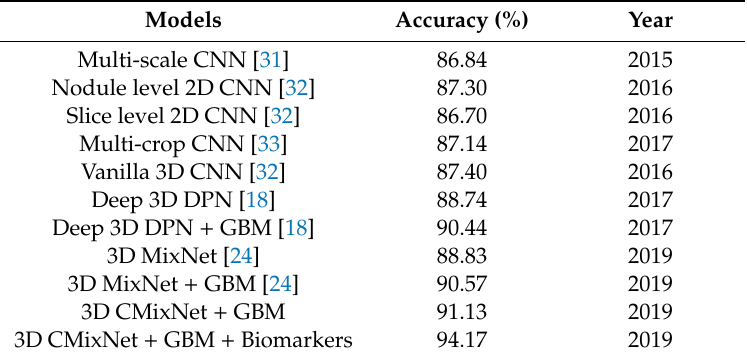
Table 5. Accuracy comparison of nodule classification on public